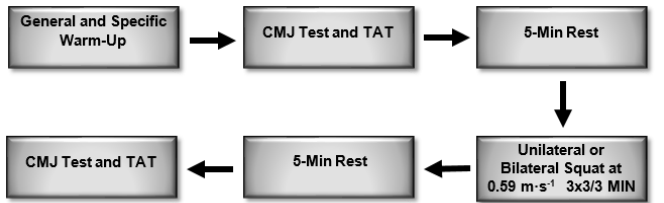
Figure 1. Protocol used for the intervention. CMJ: countermovement jump; TAT: T-agility test.